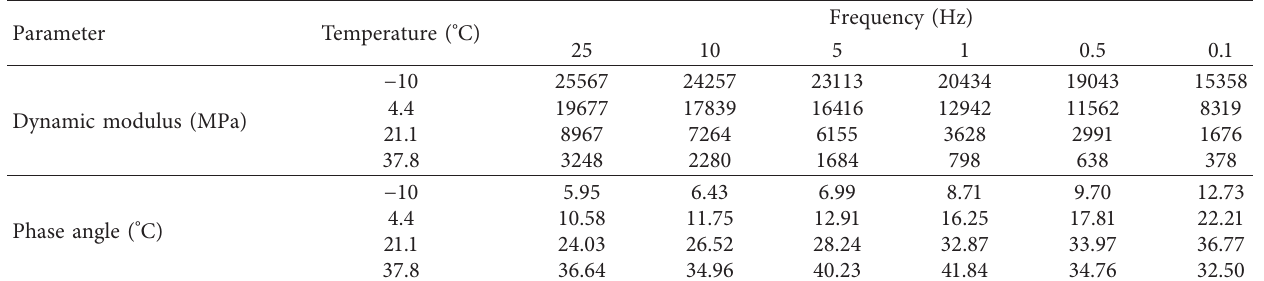
Table 11: The dynamic moduli and phase angles of the AC-13 mixtures.